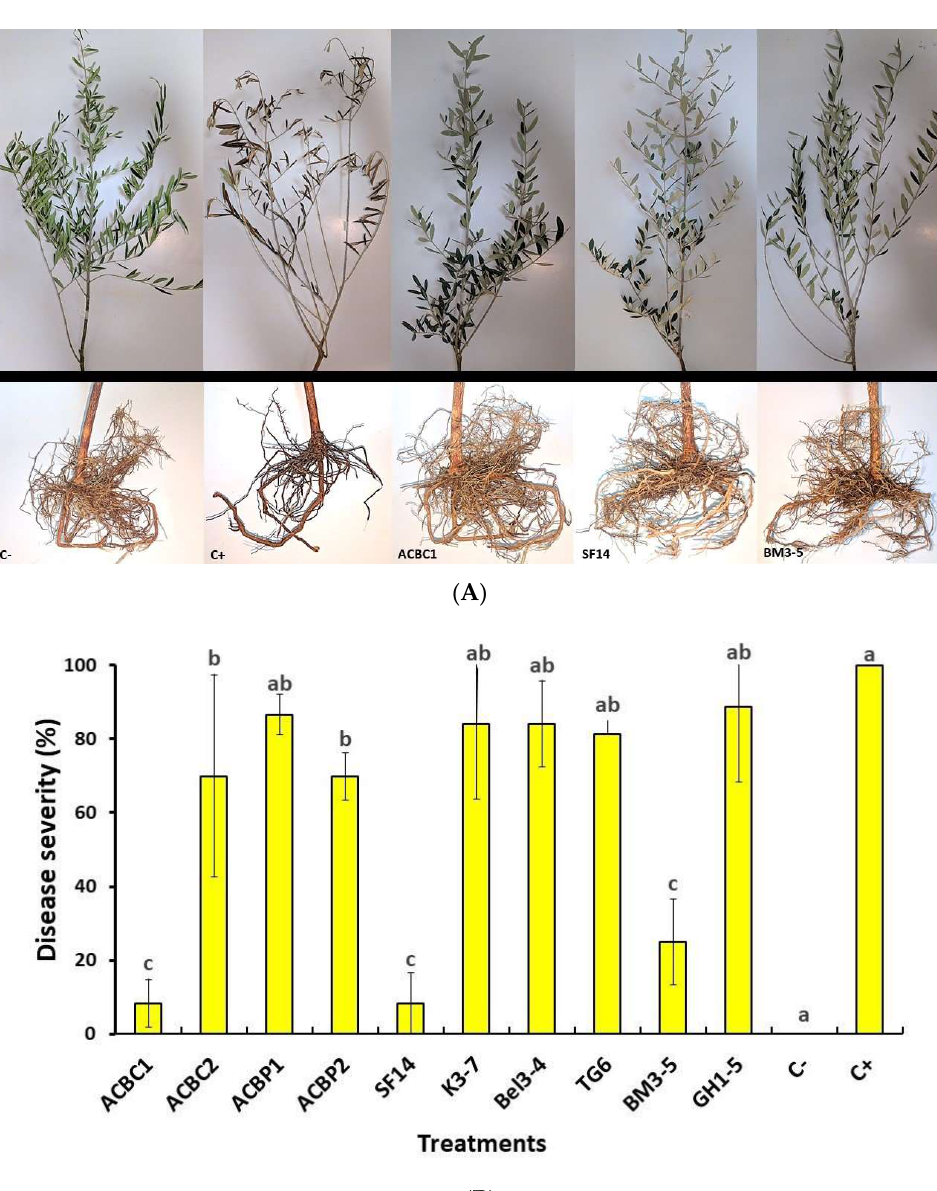
Figure 5. ( A ) Symptoms of olive root rot disease on a one-year-old plant treated with bacterial isolates ACBC1, SF14, and BM3-5 and inoculated with P. schmitthenneri after two months within glasshouse conditions. C+: positive control (olive plants inoculated only with the pathogen), and C−: negative control (plants treated only with water in the absence of the pathogen). ( B ) Observation of disease severity (%) on the root of olive trees treated with bacterial suspension of the ten isolates (2 × 10 8 CFU/mL) and inoculated with P. schmitthenneri , after 2 months of incubation at 25 °C within greenhouse conditions. C+, positive control (pathogen only), and C−, negative control (plants treated only with water in the absence of the pathogen). Histograms represent the mean value of disease severity of two trials over time with six replicates. Error bars represent standard error, and values of plant severity with the same letter were not significantly different according to the Tukey test ( p ≤